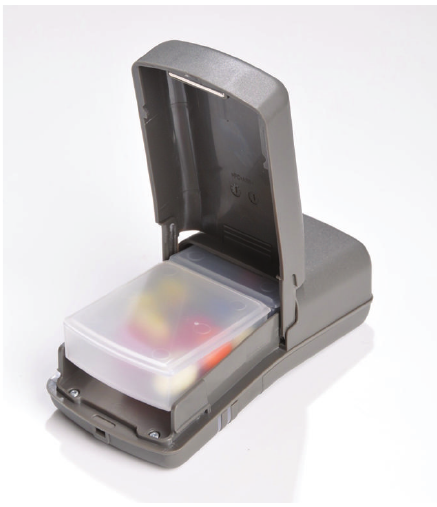
Figure 1: The Wisepill